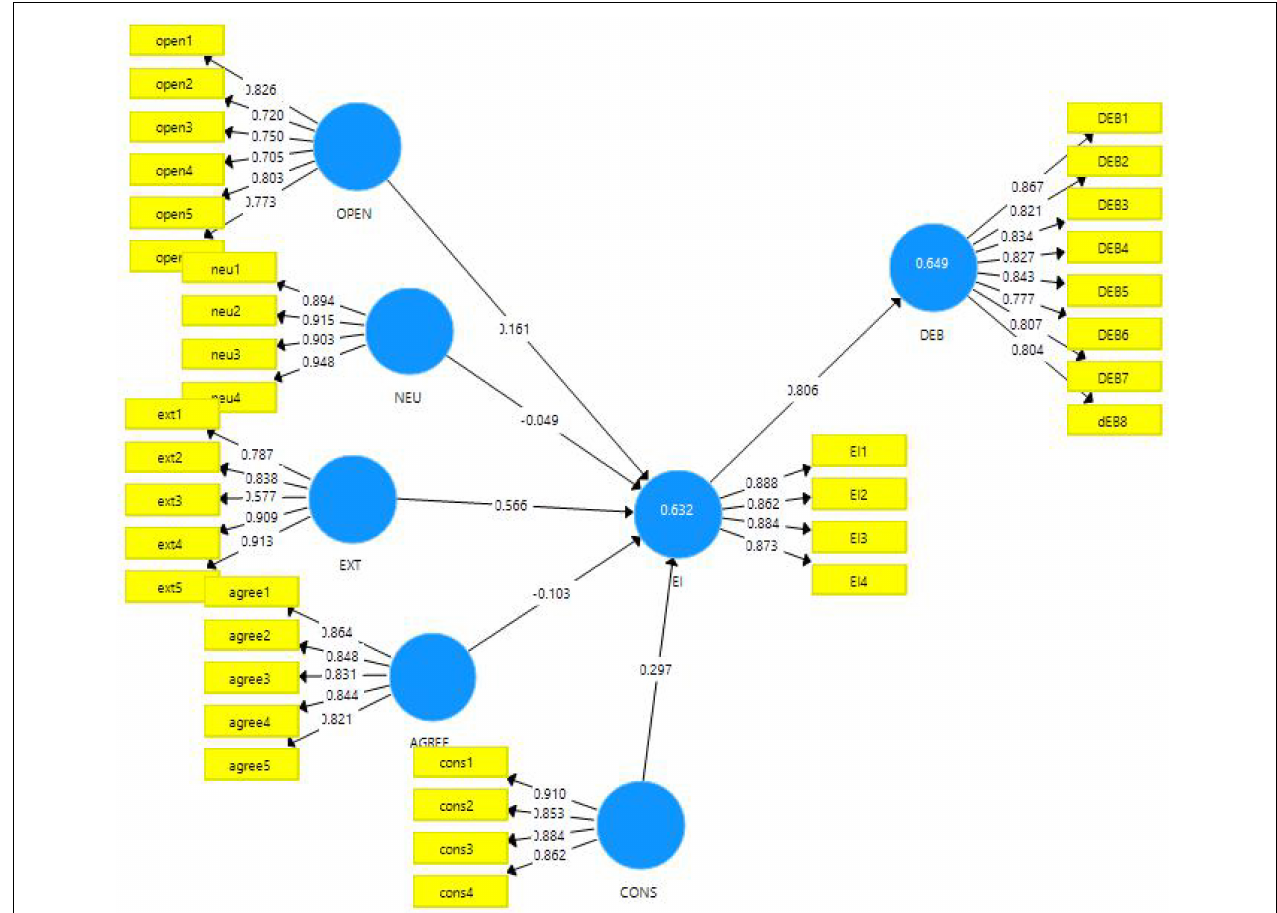
FIGURE 3 | Measurement model algorithm